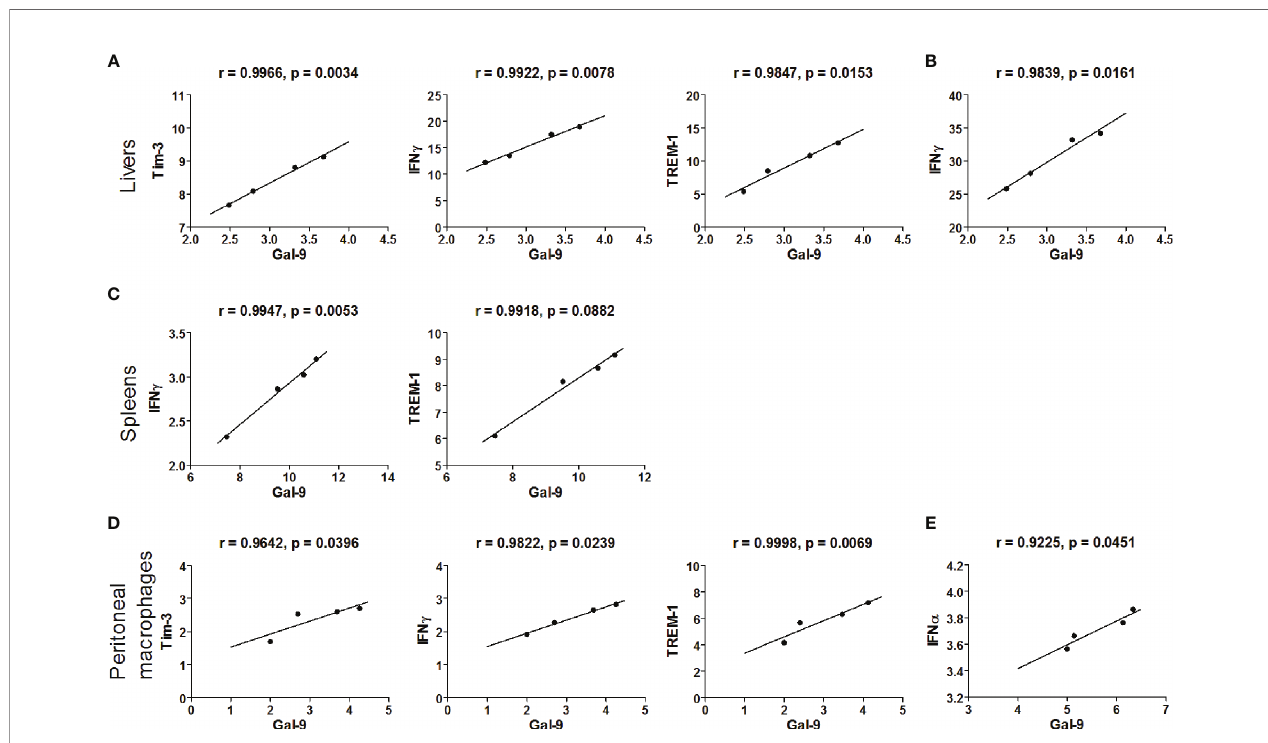
FIGURE 9 | Correlation analysis between Gal-9 and Tim-3, IFN a , IFN b , IFN g , or TREM-1 mRNA expression levels in the livers, spleens, and the peritoneal macrophages ex vivo from malarial mice and malarial mice with a -lactose treatment ( n = 4). Signi fi cant correlations between Gal-9 and Tim-3/IFN g /TREM-1 level in the livers of malarial mice (A) and signi fi cant correlations between Gal-9 and IFN g level in the livers of malarial mice with a -lactose treatment (B) . Signi fi cant correlations between Gal-9 and IFN g /TREM-1 level in the spleens of malarial mice (C) . Signi fi cant correlations between Gal-9 and Tim-3/IFN g /TREM-1 level in the peritoneal macrophages isolated from malarial mice (D) and signi fi cant correlations between Gal-9 and IFN a level in the peritoneal macrophages isolated from malarial mice with a -lactose treatment (E) . The r value generates for the theoretical line of best fi t, and the P value indicates the signi fi cance of the